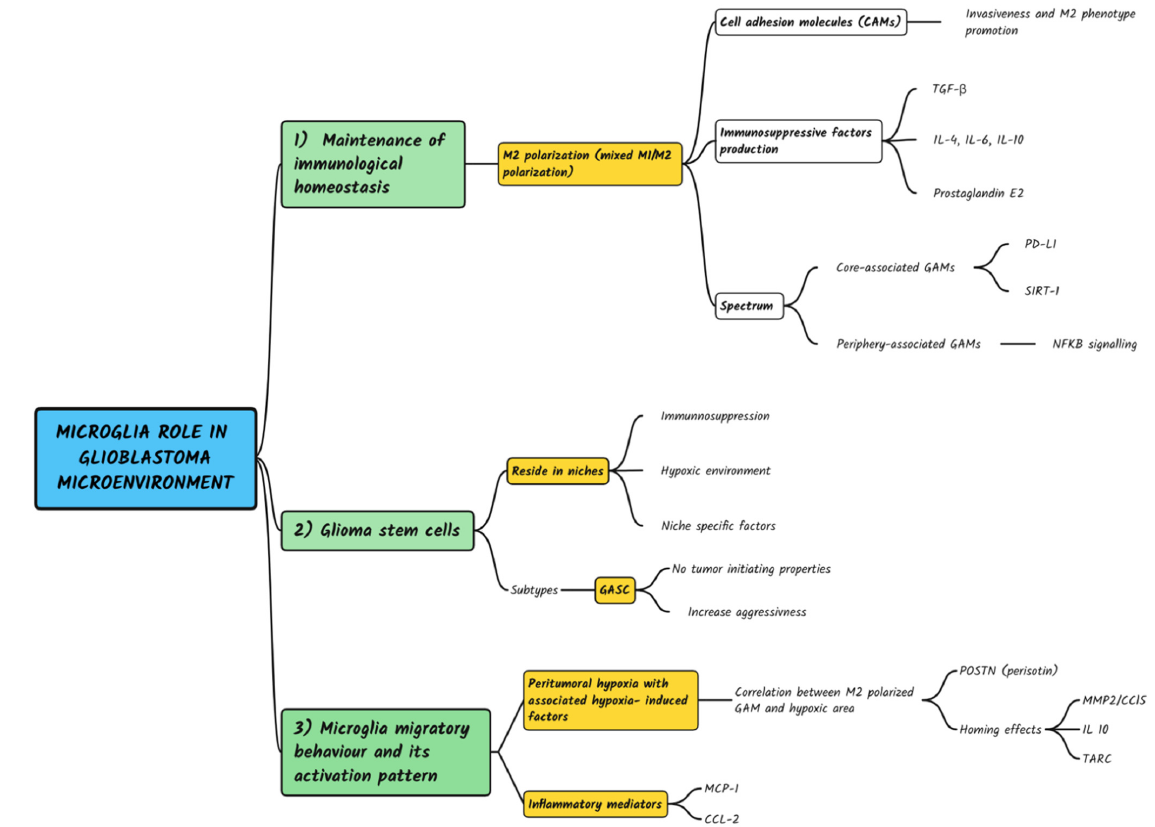
Figure 2. Schematic representation of multiple roles of microglia in Glioblastoma development, pathogenesis and relapse according a ‘seed and soil’ aproach.